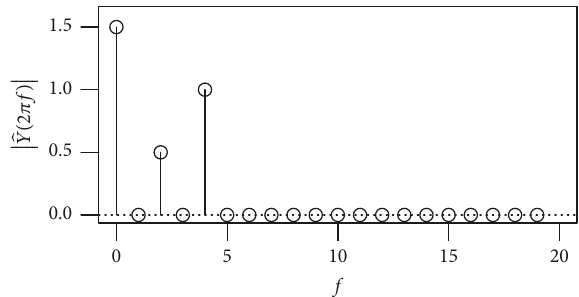
Figure 7: Single sided spectrum of the analytic signal of 𝑦(𝑡)